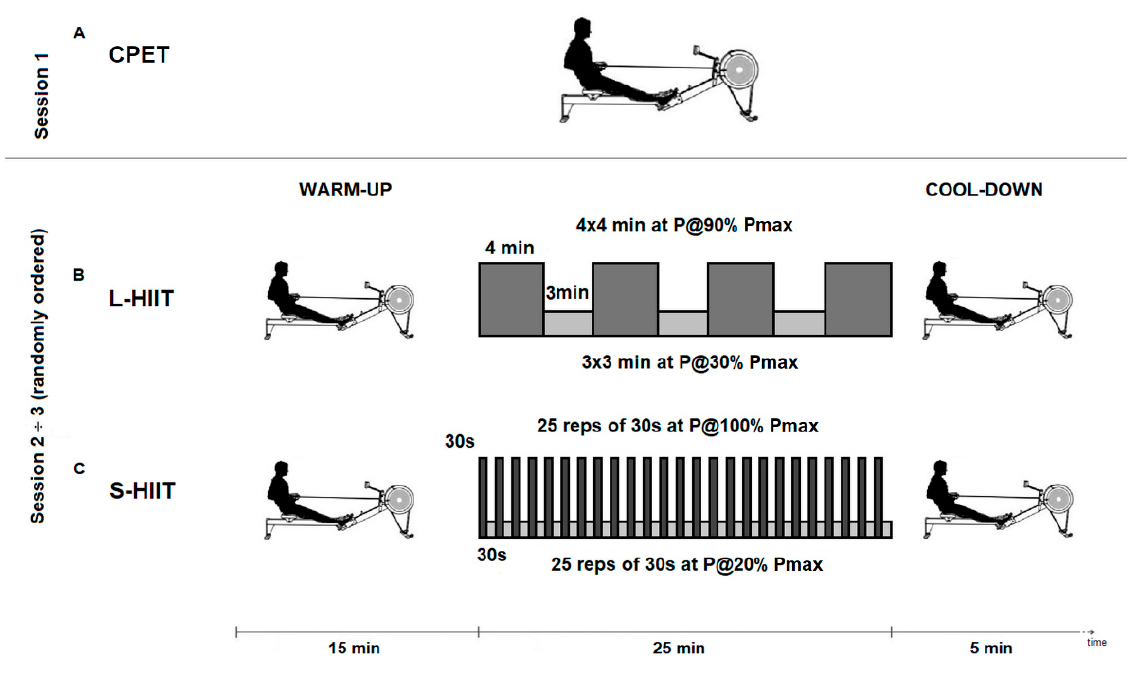
Figure 1. Experimental design: ( A ) the CPET session; ( B ) the L-HIIT testing session; ( C ) the S-HIIT testing session. CPET, cardiopulmonary exercise test; HIIT, high-intensity interval training; L-HIIT, long high-intensity interval training; S-HIIT, short high-intensity interval training; P, power; Pmax, power at VO 2 max.